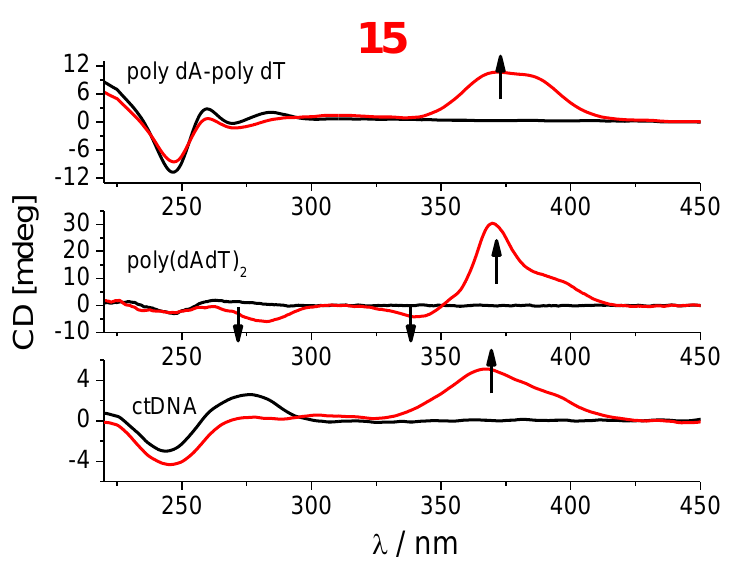
Figure 4. CD titrations of ctDNA, poly(dAdT) 2 and poly dA- poly dT ( c = 3.0 × 10 −5 mol dm −3 ) with 15 at molar ratios r = [compound]/[polynucleotide] = 0.5; (polynucleotide –, complex –), pH = 7.0, buffer sodium cacodylate, I = 0.05 mol dm −3 .